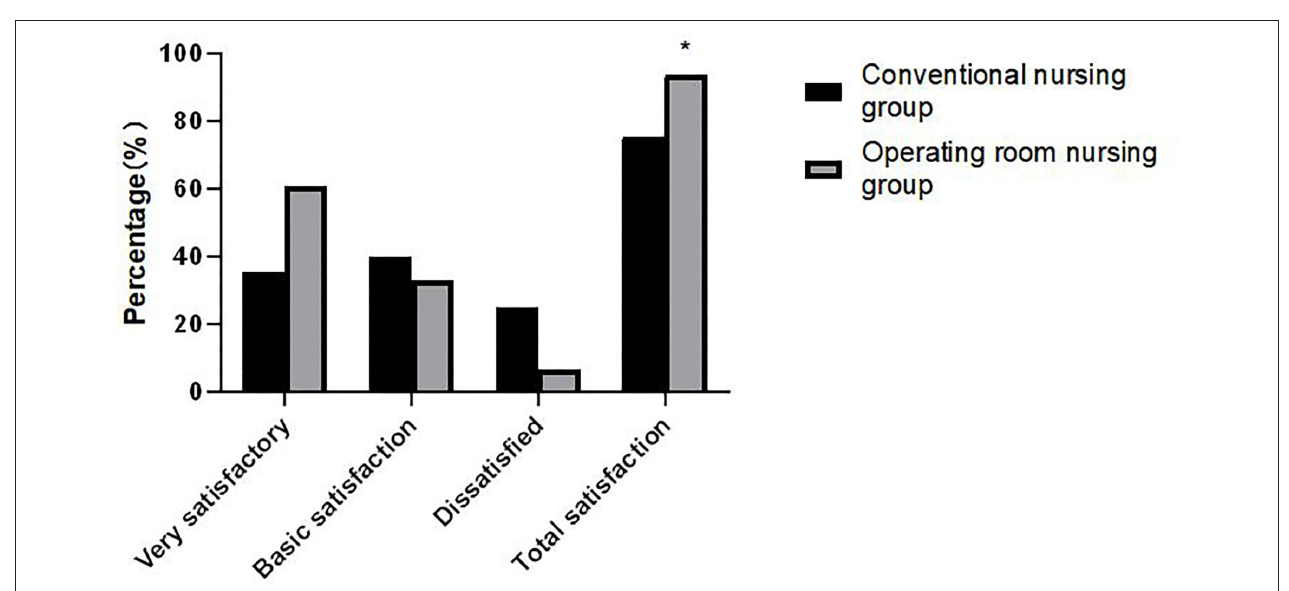
FIGURE 5 | Comparison of nursing satisfaction between the two groups. Compared with the conventional nursing group, * p < 0.05. incision using normal saline irrigation in order to block the path of bacterial infection, and avoid infection